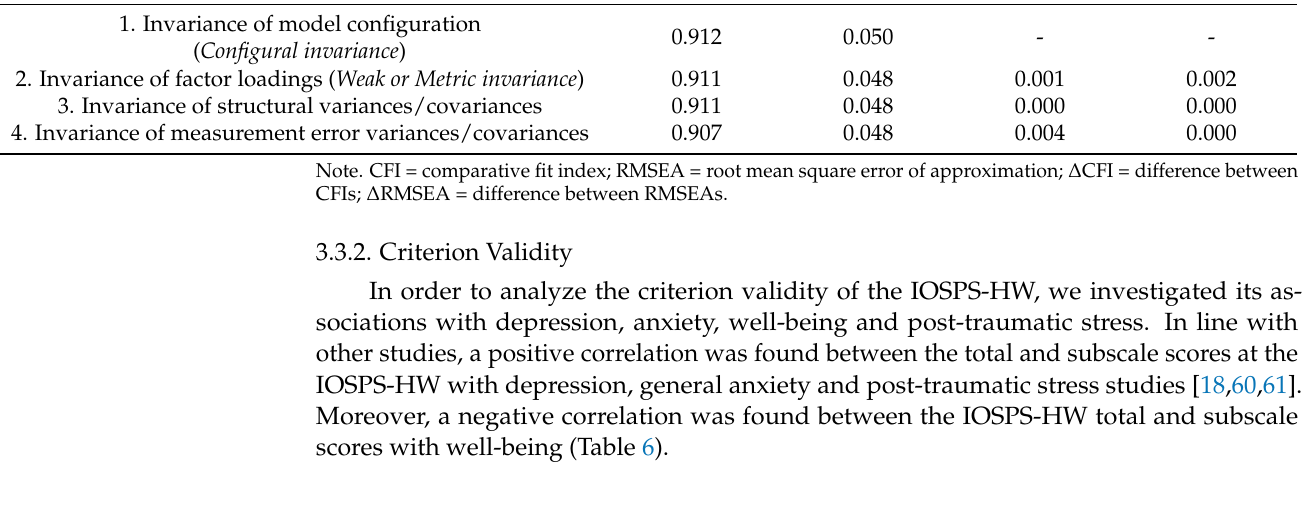
Table 5. Goodness-of-fit statistics for each level of structural and measurement invariance across T0 and T1 samples for the Individual and Organization related Stressors in Pandemic Scale for Healthcare Workers (IOSPS-HW). CFI ∆